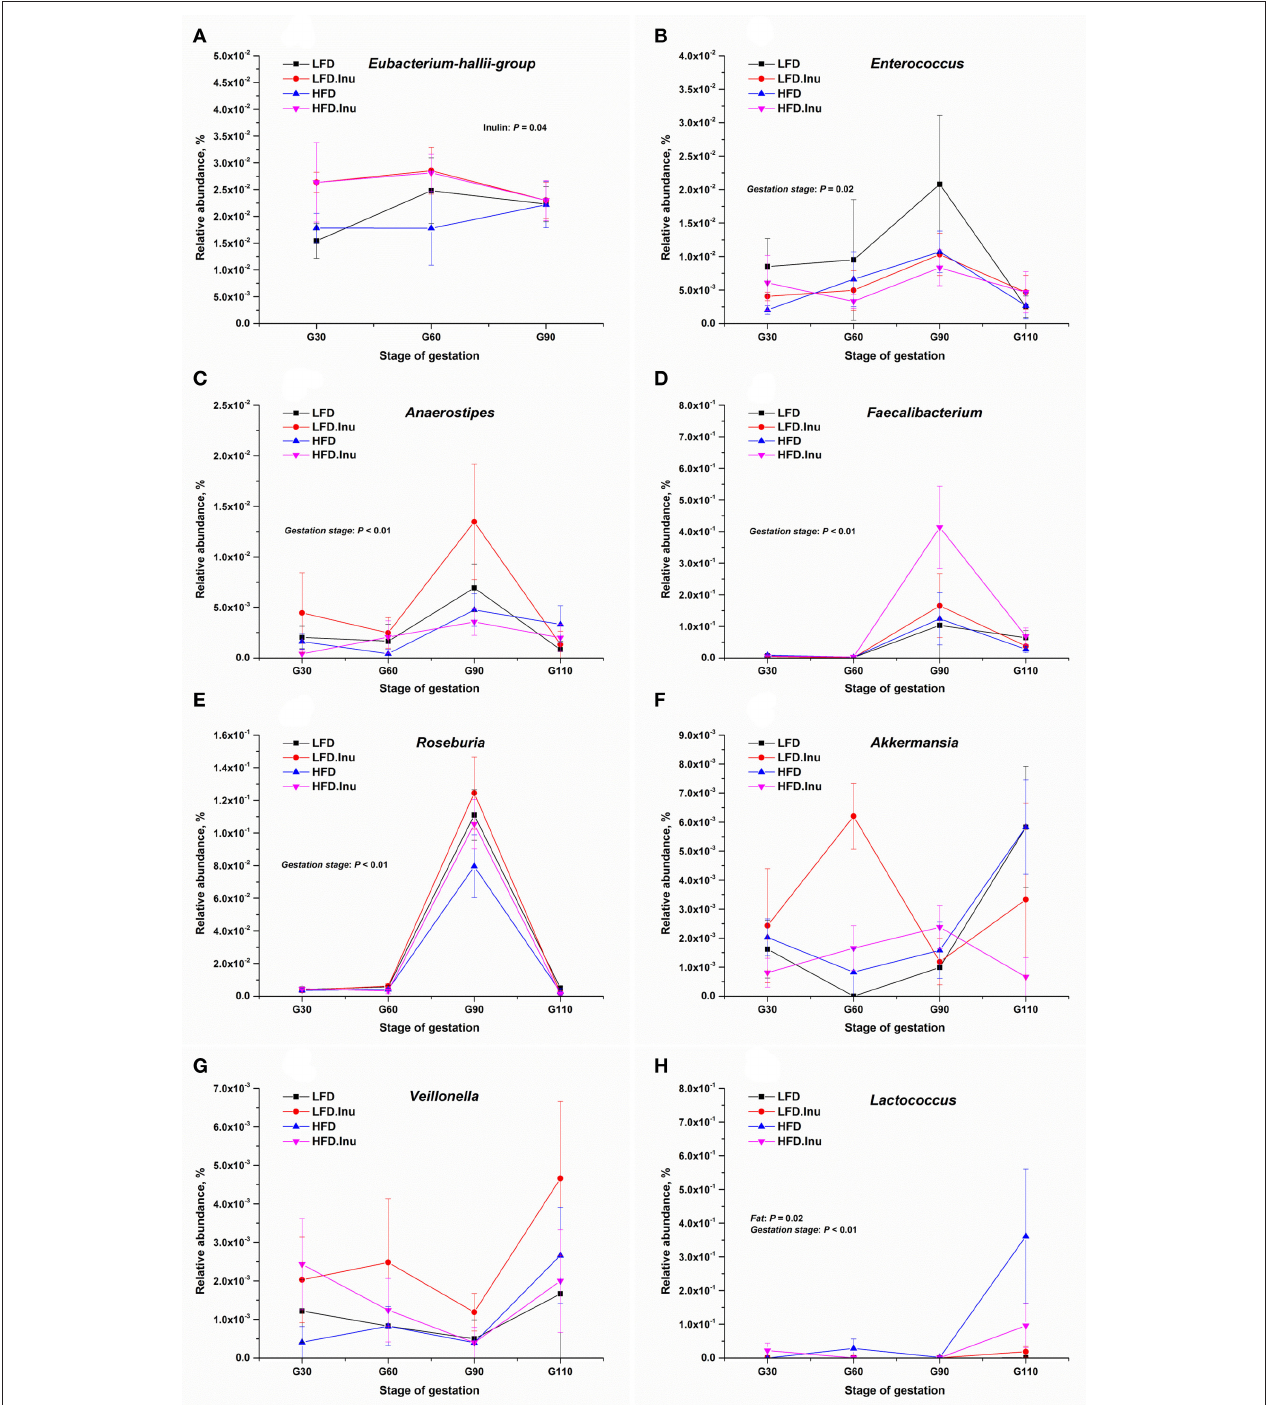
FIGURE 5 | The relative abundances of representative VFA-producing related genera (%) during gestation. (A) Eubacterium-hallii-group : P = 0.04 for inulin effect. (B) Enterococcus : P = 0.02 for gestation stage. (C) Anaerostipes : P < 0.01 for gestation stage. (D) Faecalibacterium : P < 0.01 for gestation stage. (E) Roseburia : P < 0.01 for gestation stage. (F) Akkermansia . (G) Veillonella . (H) Lactococcus : P = 0.02 for fat effect and P < 0.01 for gestation stage. Data were log-transformed following the addition of a small offset (0.00001) to counteract the presence of zero values before statistical analysis. Sows were regarded as the experimental units, n = 5 for each treatment at each gestation stage except for LFD group with n = 4 on d90 and d110 of gestation due to an unexplained diarrhea on d88 of gestation which lasted for 2 days. When significant main effects or interative effects were observed, the means were compared using the least significant difference method with a P < 0.05 indicating significance. LFD, low fat diet; LFD.Inu, low fat diet with inulin addition; HFD, high fat diet; HFD.Inu, high fat diet with inulin addition. Only significant p -values were presented in the figure.